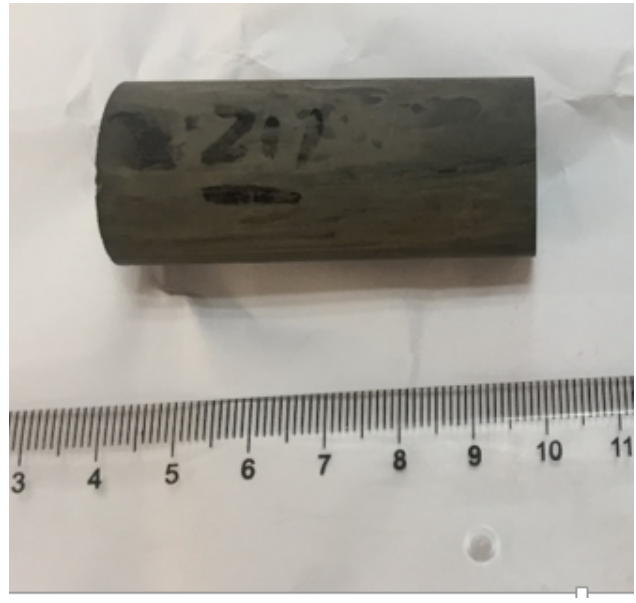
Figure 1. Images of shale